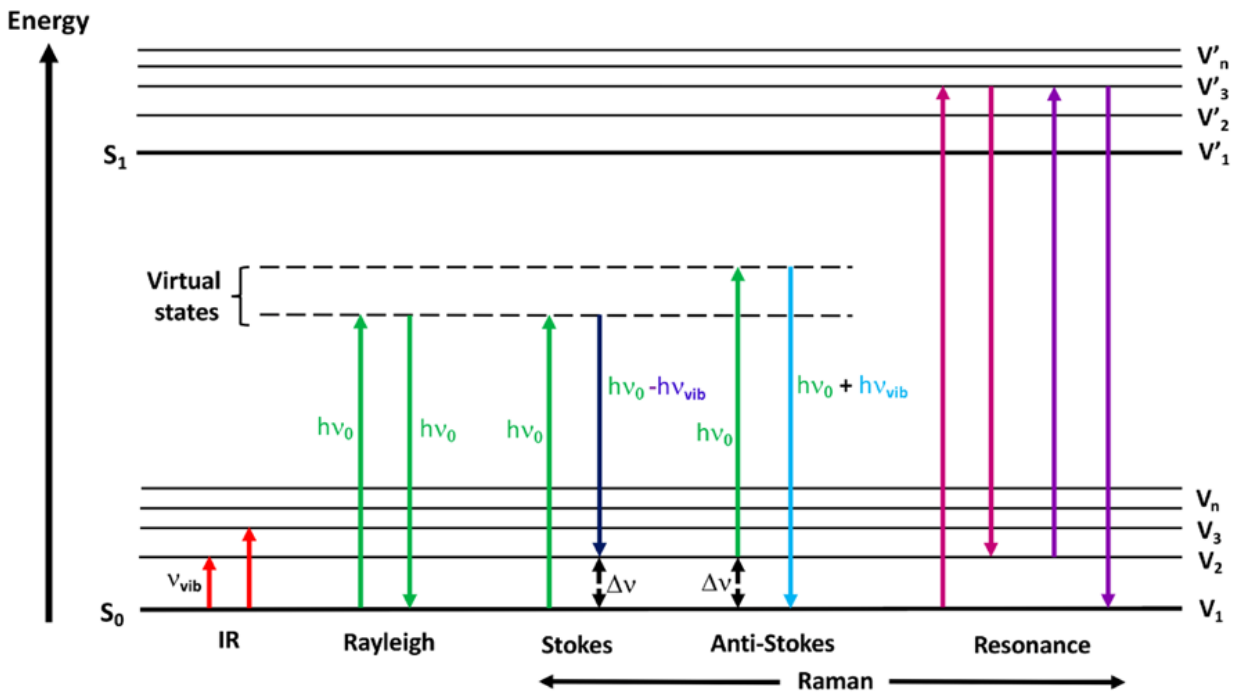
Figure 1. Jablonski energy diagram showing the transitions involved during infrared absorption, Rayleigh, Raman Stokes, anti-Stokes, and resonance Raman scattering as reported by Geraldes [20]. Reprinted from Ref. under CC BY 4.0.